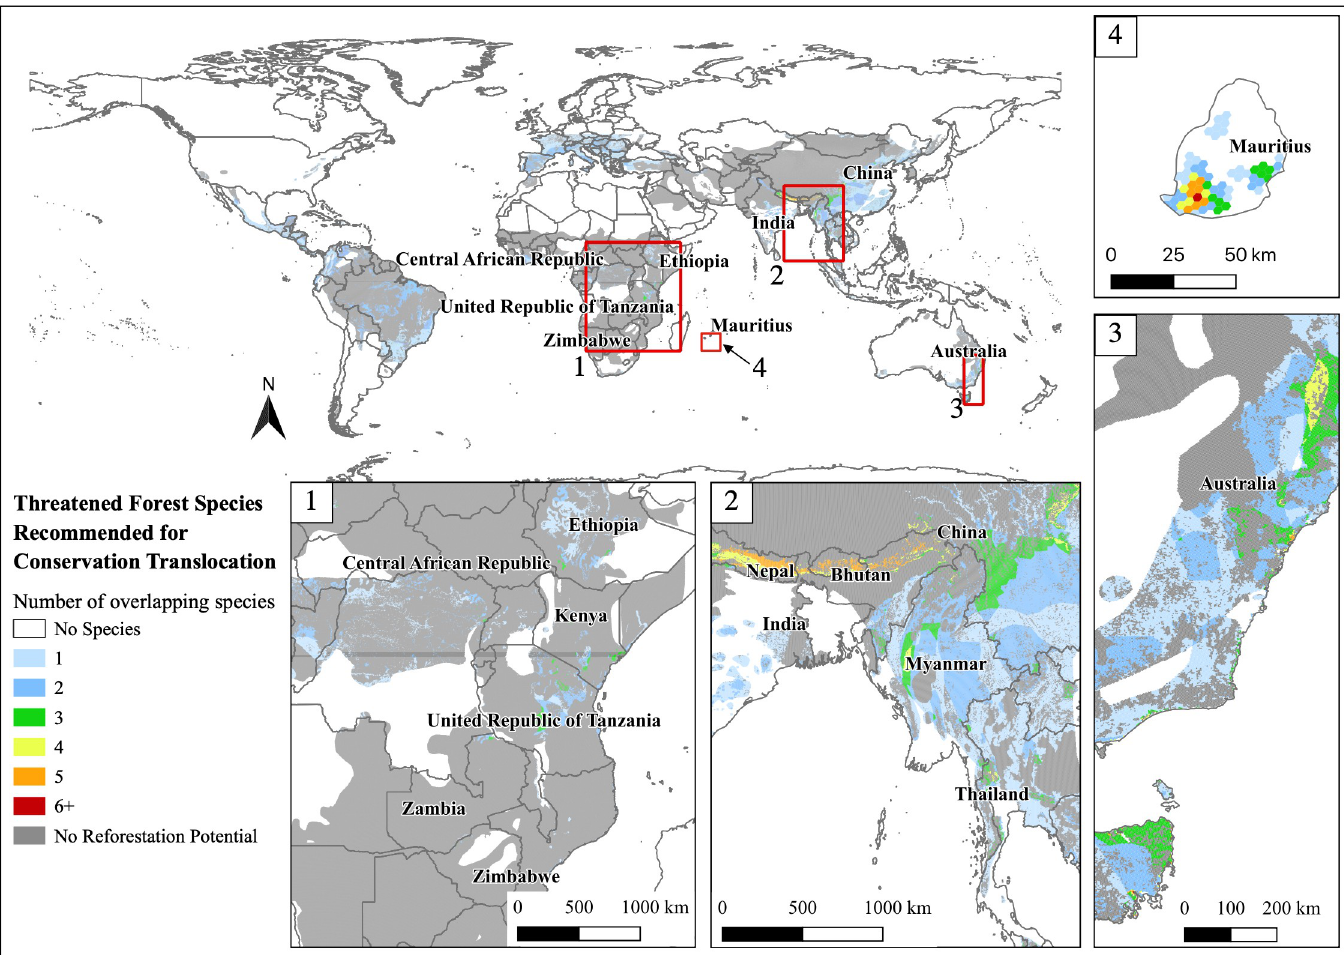
Fig 2. Overlapping species range maps with restoration potential for 152 threatened and Near Threatened terrestrial species, amphibians, birds, mammals, that live in forest habitat with CT as a recommended conservation action. Areas in grey indicate where restoration species’ home ranges exist, but there is no potential for habitat restoration. White areas indicate where no species with recommended CT occur. Reprinted partially from the Environmental Systems Research Institute (ESRI) under a CC BY license, with permission from ESRI, original copyright 2021.